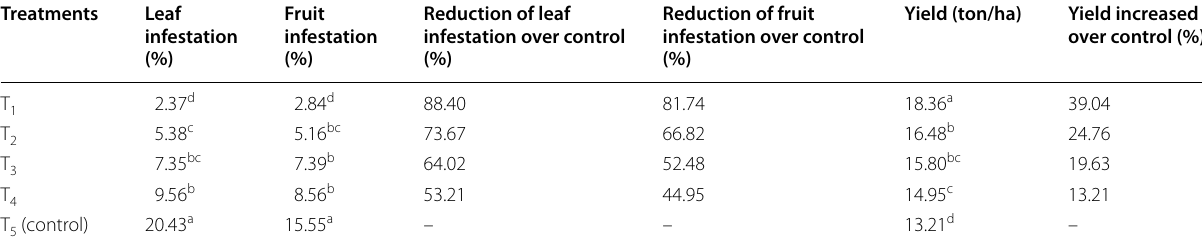
Table 5 Efficacy of different pest management modules on leaf and fruit infestation by hog-plum beetle, P. 14-punctata under field condition during 2018